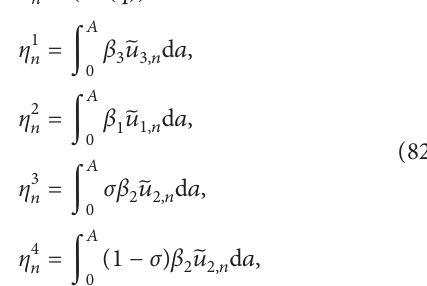
Figure 1: Initial